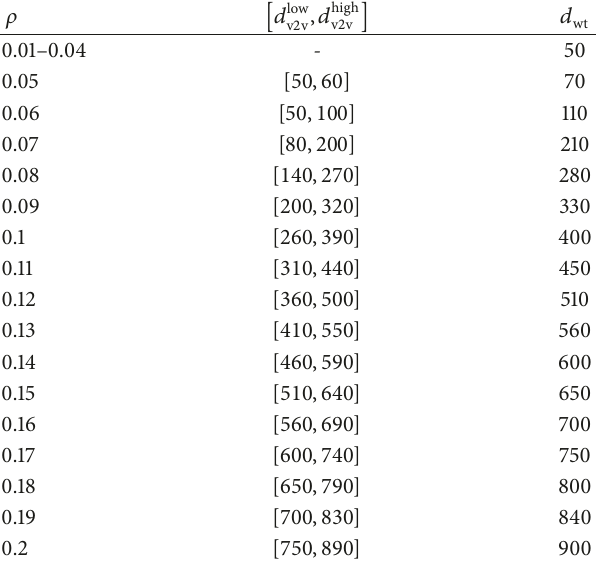
, 𝑑 high ] for traffic accidents v 2 v v 2 v in different wt